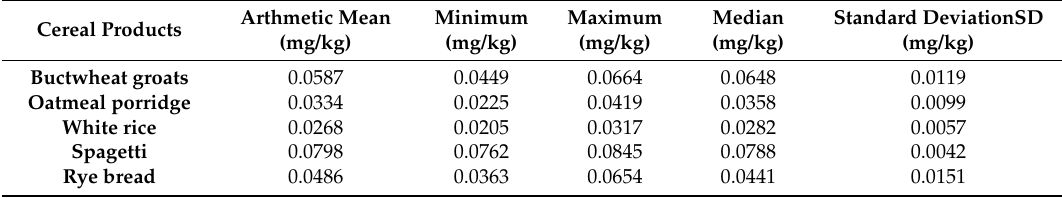
Table 1. Thallium concentration (mg/kg) in consumable commercial grain